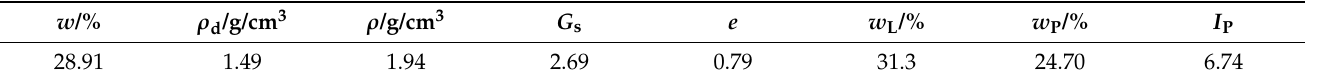
Table 1. Physical properties of the silt.